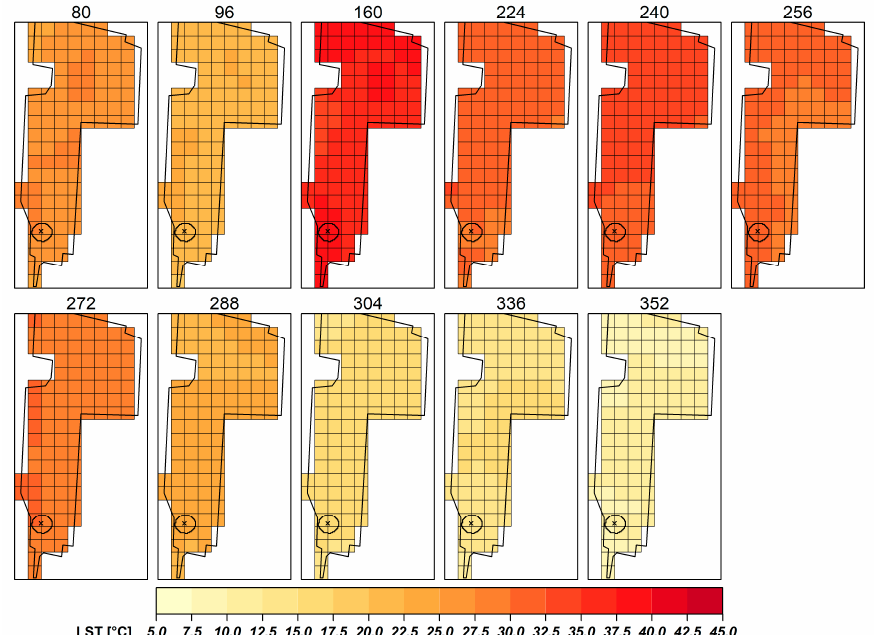
Figure 4. Land surface temperature (LST) for the whole vineyard in 2011 from eleven Landsat 7 images between DOY 80 and DOY 352. The cross shows the position of the EC system with the 80% footprint area.